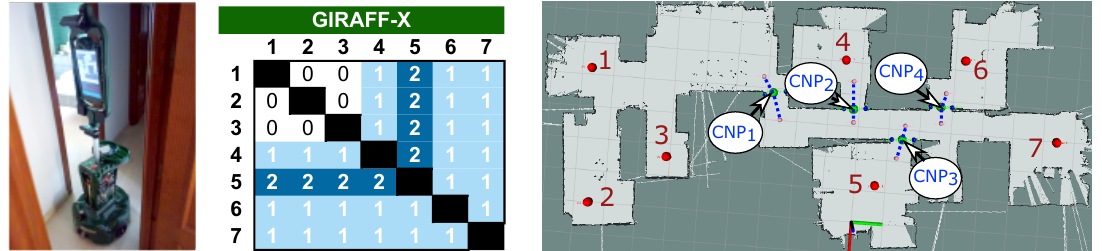
Figure 8. Picture of the Giraff.X robot during the real experiment ( left ) and results obtained ( middle ) for each navigation path in the environment ( right